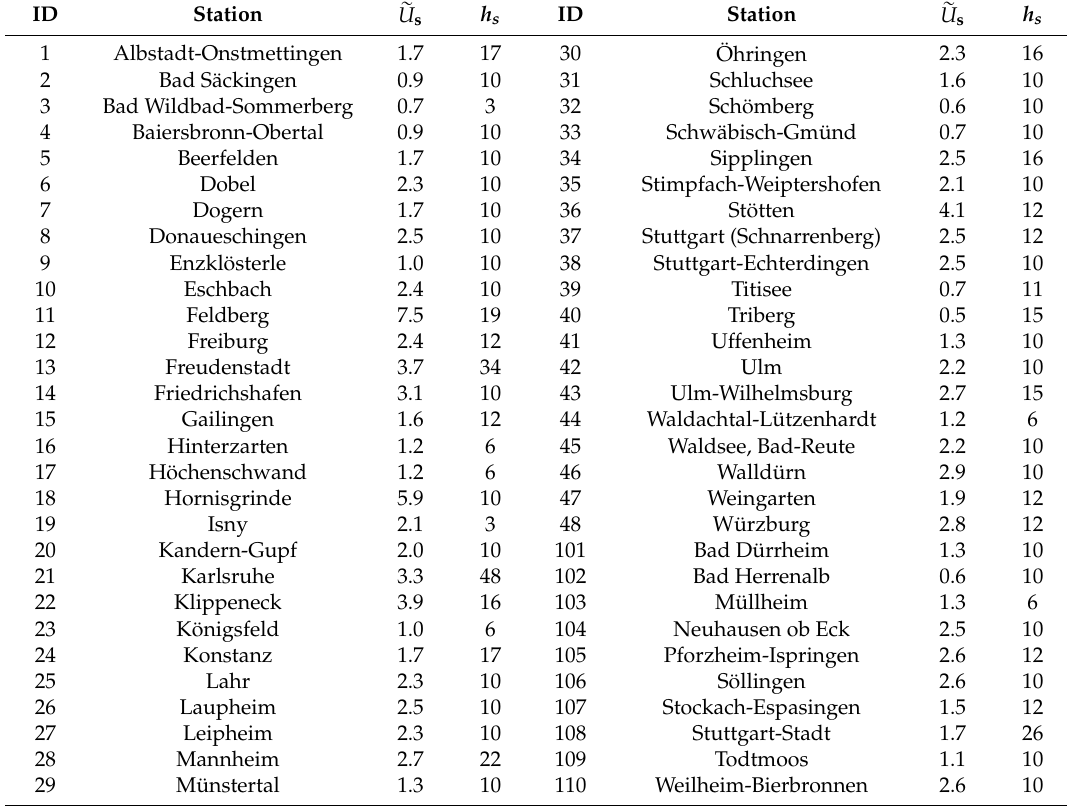
U~ : median wind r U s : median